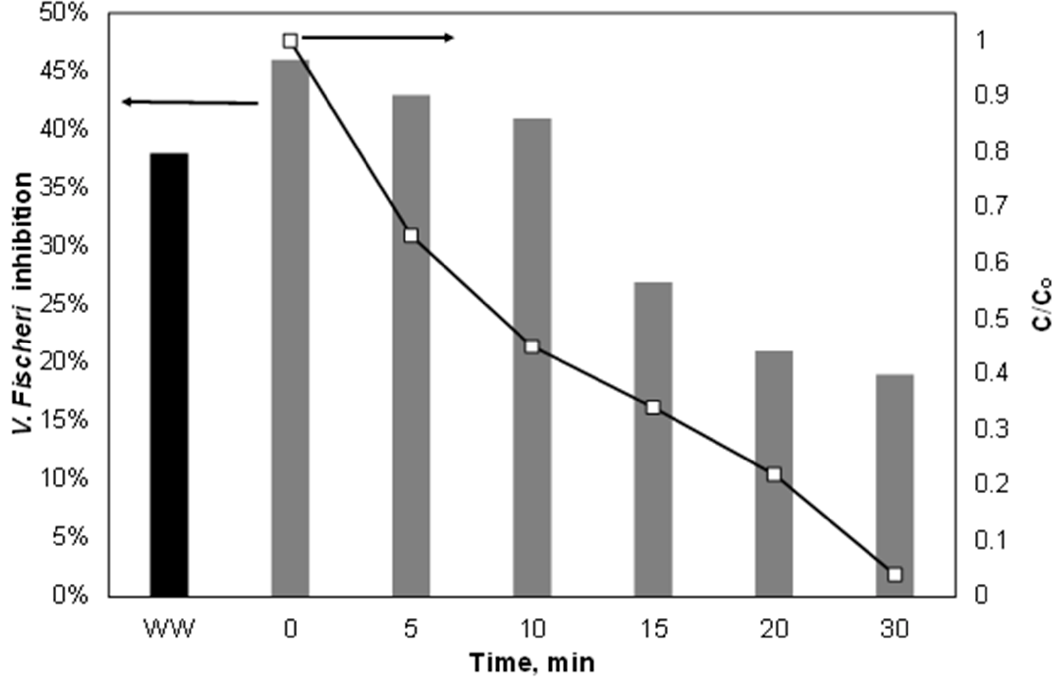
Figure 9. Variation of PIR and toxicity during the Fe 2+ /SPS treatment in secondary effluent. [PIR] = 500 µ g/L, [Fe 2+ ] = 2 mg/L, [SPS] = 20 mg/L, ultrapure water and inherent pH.